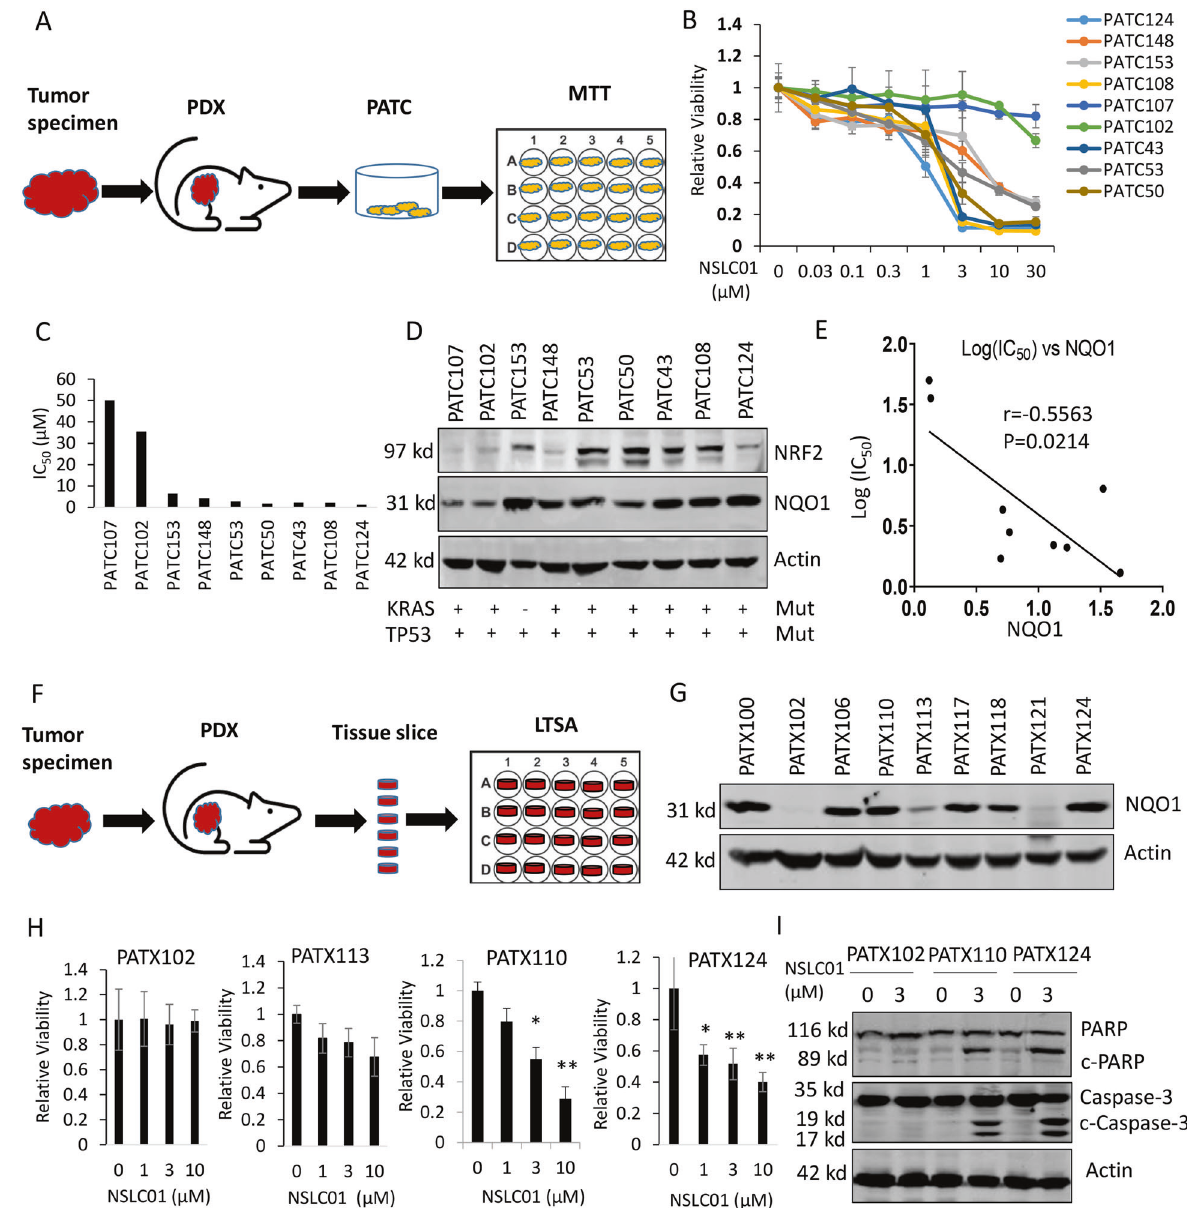
Fig. 3 NSLC01 inhibited the viabilities of patient-derived pancreatic cancer cells and ex vivo-cultured PDX tumor tissues. A Schematic illustration of establishing patient-derived pancreatic cancer cells from PDX tumors for drug activity testing. B Response pro fi le of patient- derived pancreatic cancer cells to NSLC01. C IC 50 of NSLC01 in nine PDX-derived pancreatic cancer cell lines. D Western blot analysis of the expression of NRF2 and NQO1 in patient-derived pancreatic cancer cells and the mutation status for KRAS and TP53 genes. E Correlation between NQO1 expression and the IC 50 values of NSLC01 in patient-derived pancreatic cancer cells. F Schematic illustration of ex vivo organotypic tissue slice culture and LTSA assay with PDAC PDX tumors. G Western blot analysis of NQO1 expression in pancreatic cancer PDXs. H Ex vivo testing of NSCL01 activity with four selected PDAC PDX models using LTSA assay. Tissue slices were generated from PDX tumors as described in method section and deployed in 96-well plate. Tissue slices were treated with indicated concentrations of NSLC01 for 72 h, then tissue slice viabilities were measured with PrestoBlue ® reagent. * P < 0.05; ** P < 0.01. Data are presented as mean ± SD, n = 3. I Western blot analysis of two apoptosis markers, cleaved PARP and cleaved caspase-3, in PDXs after treatment with